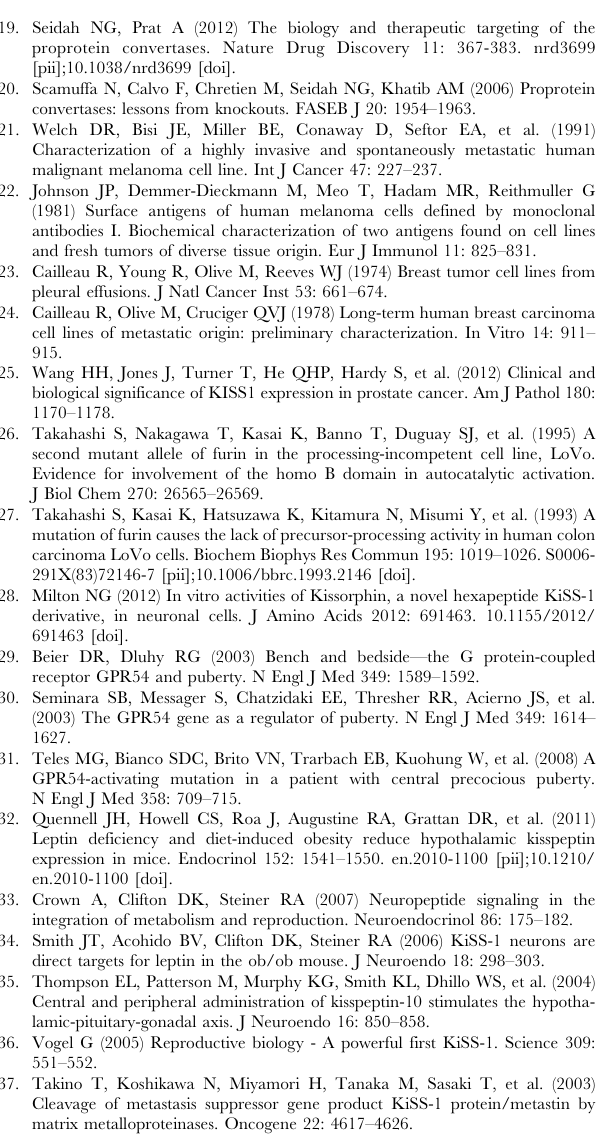
Figure S2 Furin interacts with KISS1 only extracellu- larly. Immunoblot showing co-immunoprecipitation of endoge- nous furin and over-expressed KISS1. Furin was immunoprecip- itated from cell lysates (L) or conditioned media (CM) in MelJuSo and C8161.9 cells and probed for interaction using